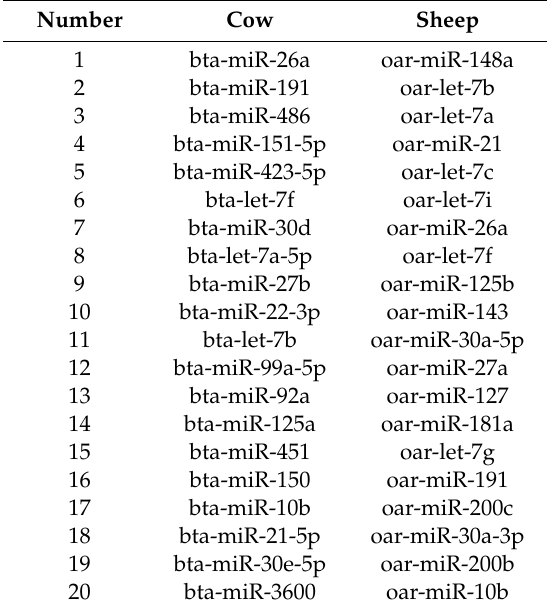
Table 2. The top 20 highly expressed miRNAs in cow and sheep milk EVs. Number Cow